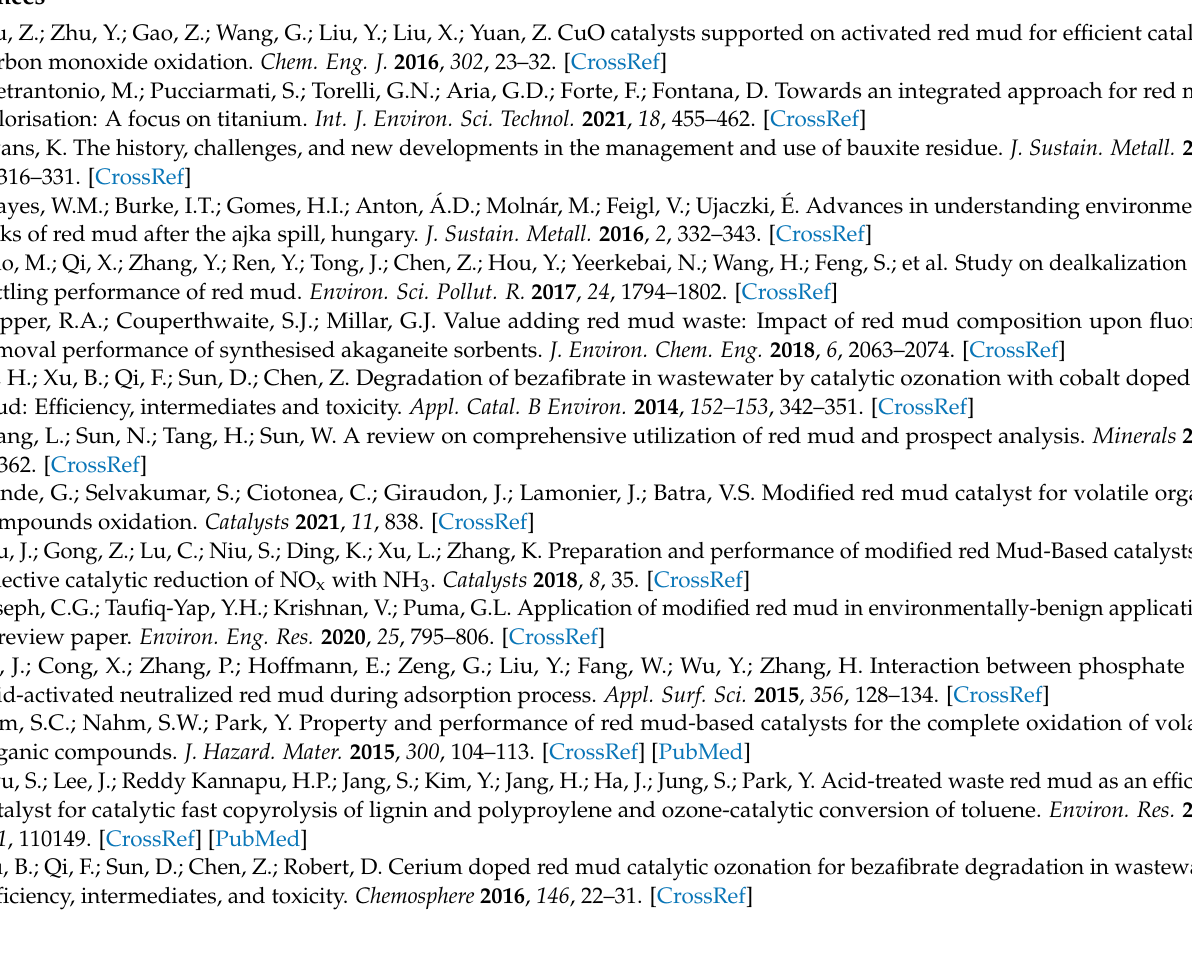
Table S3: Construction of pairwise comparison matrix; Table S4: The value standard of RI; Table S5: Judgment matrix of evaluation layer to target layer and single ranking result; Table S6: Judgment matrix and single ranking result of index layer’s impact on Environment; Table S7: The judgment matrix of economic benefit in index level and the result of single rank; Table S8: Judgment matrix and single ranking result of energy consumption in index layer; Table S9: The total ranking weight of each index layer; Table S10: Comprehensive evaluation index classification of Mn/Ce@RM based ozone catalyst; Table S11: Qualitative index evaluation standard; Table S12: Summary of experimental results; Text S1: The calculation of index weight and consistency check, the calculation of index membership, and the structure of factor evaluation set